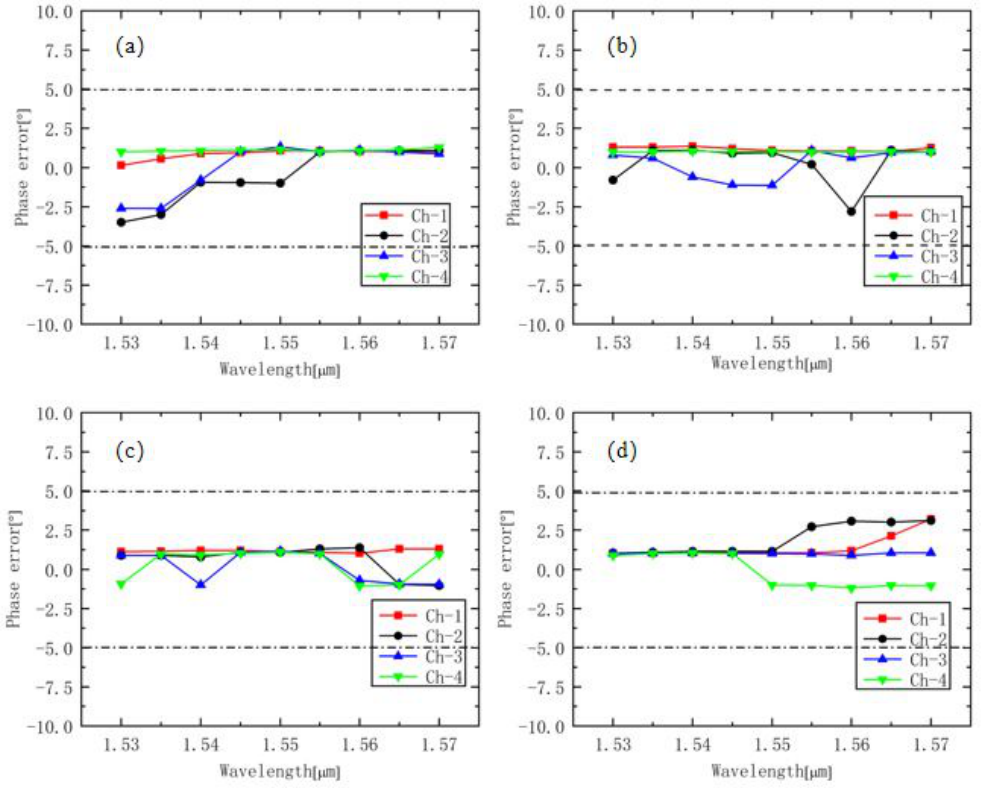
Figure 8. Simulated phase error of the hybrid with different interference lengths of ( a ) 832 μm, ( b ) 837 μm, ( c ) 847 μm, and ( d ) 852 μm across the C-band.